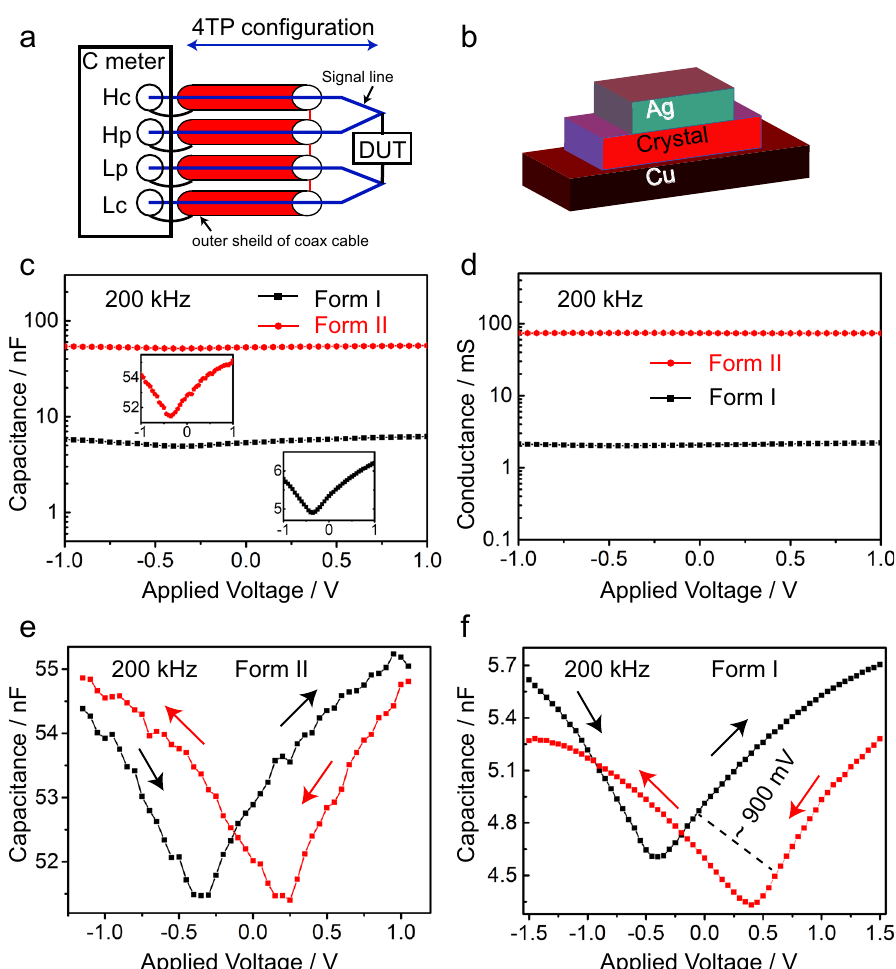
Fig. 4 Electrical measurements of GN showing the frequency-dependent capacitance – voltage ( C – V ) and conductance – voltage ( G – V ) plots. a Four- terminal-pair con fi guration (HC: high current, HP: high potential, LP: low potential, LC: low current). b Schematic of the fabricated Ag/crystal/Cu capacitor. c Capacitance – voltage ( C – V ) measurement on a single crystal of form I GN. Later the same crystal was heated, transformed to form II, and used for the C – V measurements. d Conductance – voltage ( G – V ) measurements of form I and form II. e , f The C – V